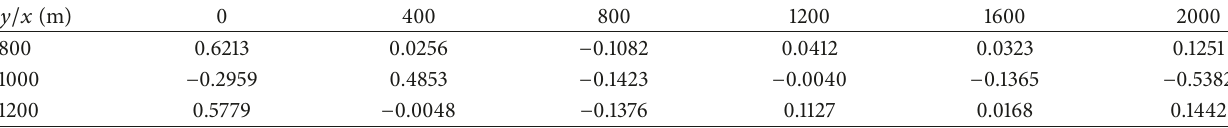
Table 4: Approximated water flow velocity in 𝑦 -direction V (𝑥, 𝑦,𝑡) (m/s).